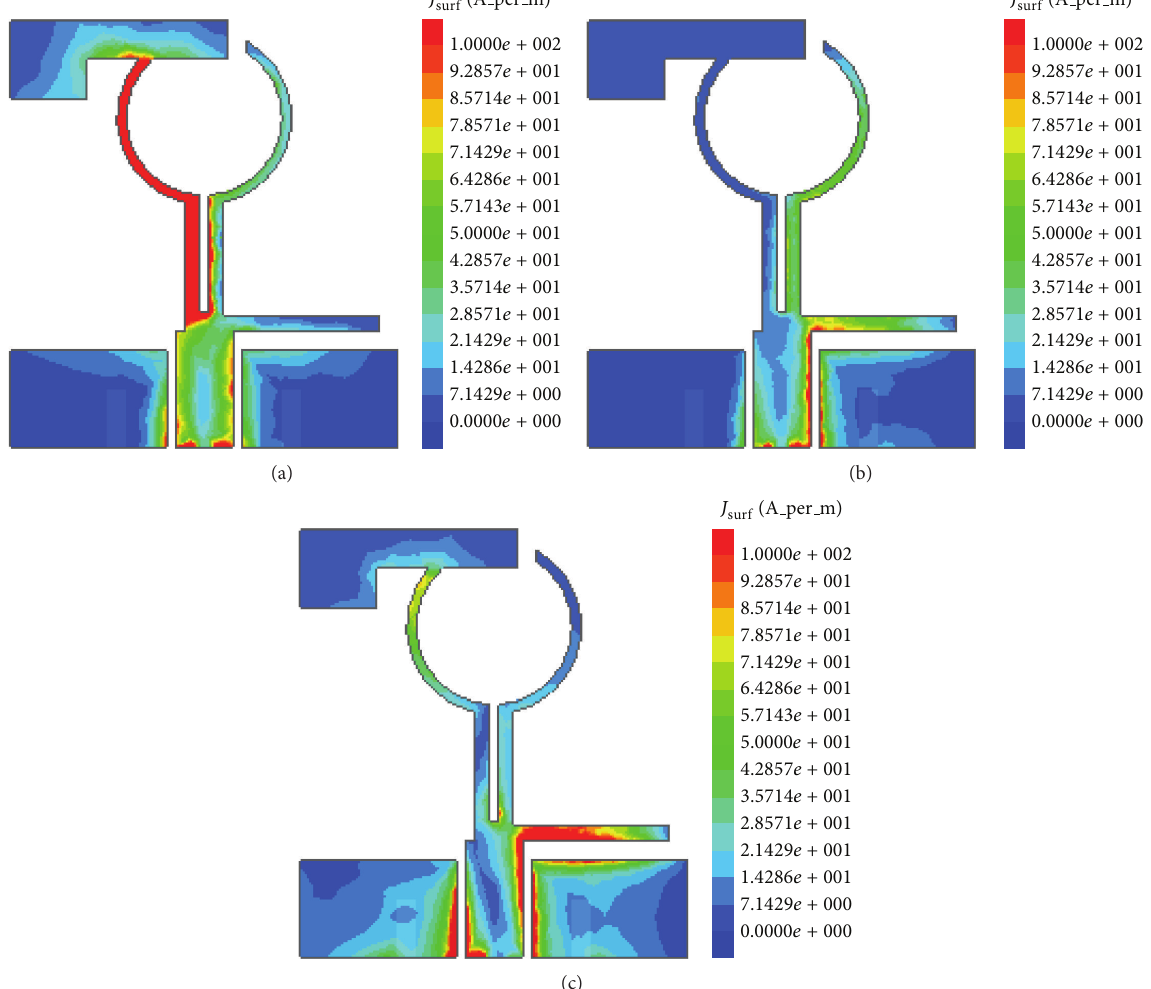
Figure 5: Surface current distributions of proposed antenna at (a) 2.4, (b) 3.5, and (c) 5.5